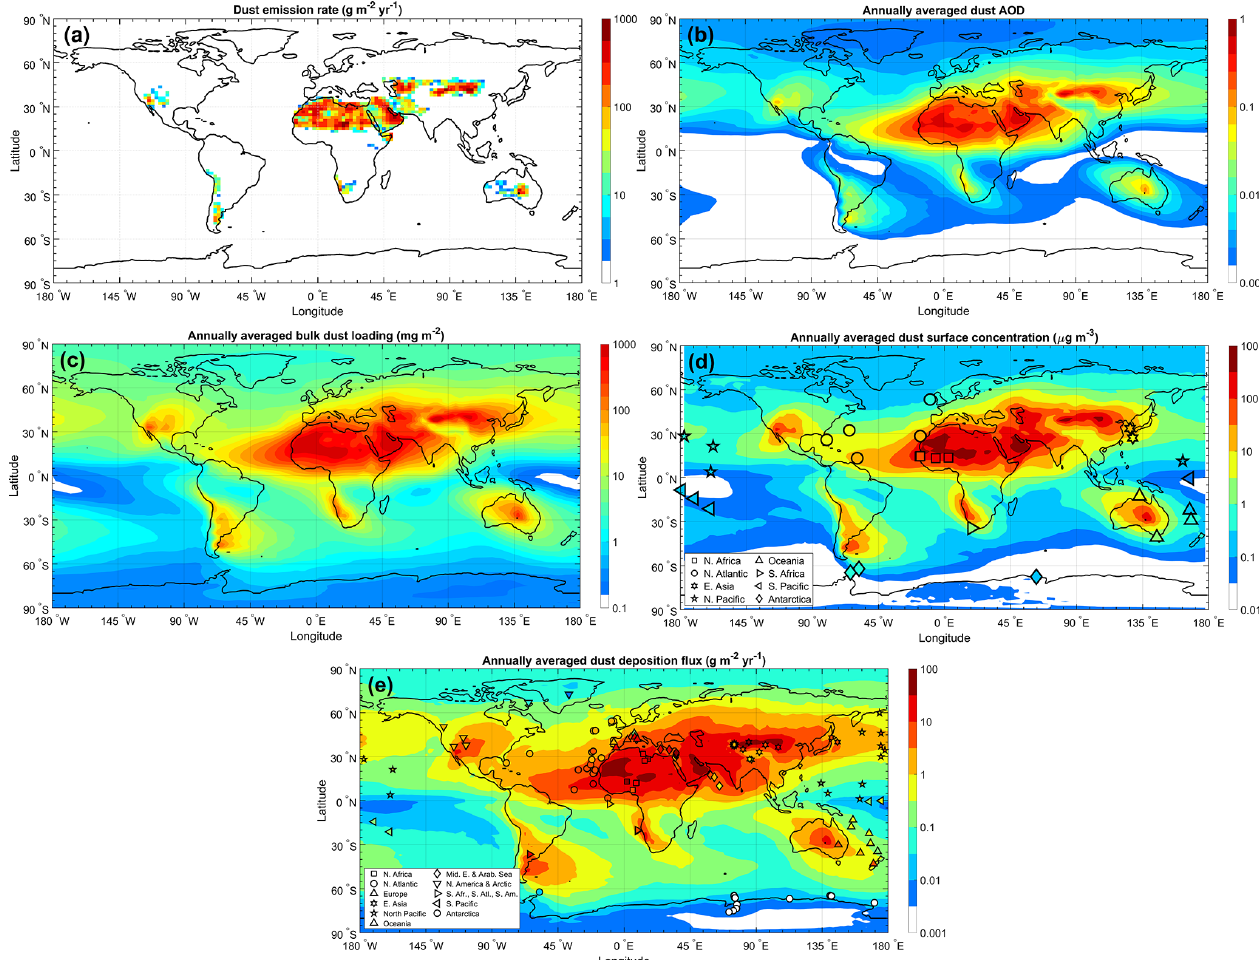
Figure 4. Predictions of key aspects of the global dust cycle. Shown are inverse model results for (a) annual dust emission rate, (b) annual dust AOD, (c) column-integrated dust loading, (d) dust surface concentration, and (e) dust deposition flux. Panels (a) – (d) show results for PM 20 dust, whereas panel (e) shows results for PM 10 dust for optimal comparison against the measurement compilation of PM 10 dust deposition fluxes (Albani et al., 2014). Seasonally resolved predictions for each of these variables are shown in Figs. S2-S6. The symbols in (d) and (e) show the locations and values of the independent surface concentration and deposition flux measurements used for evaluation of the inverse model in Sect. 4.3 (see also Fig. 2c,